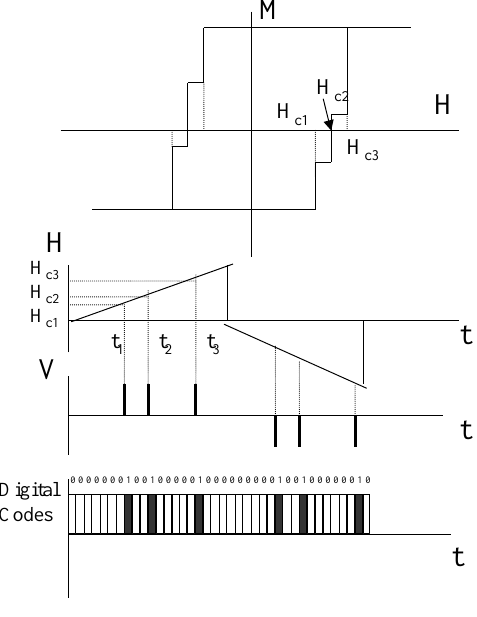
Figure 13. Schematic representation of the encoding system based on magnetic bistability of the microwires